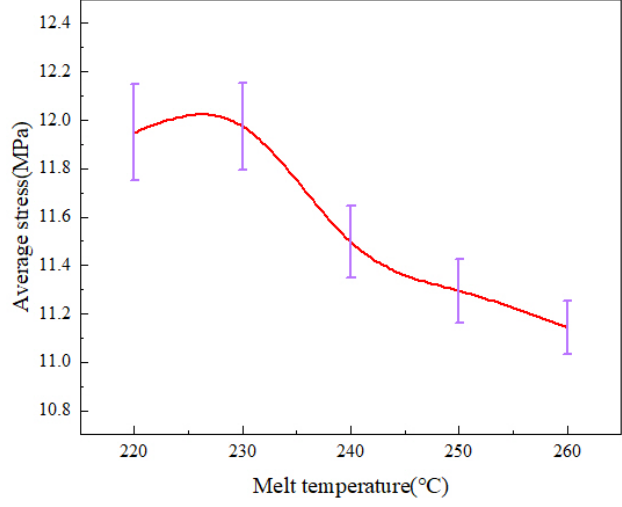
Figure 20. Average stress variations at different melt temperatures along the centerline of the parts.